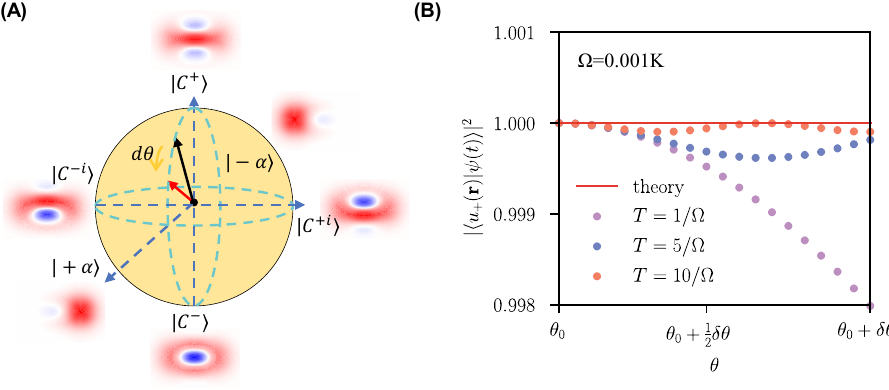
Figure 3. The dynamics process of the adiabatic evolution. ( A ) The Bloch dynamics process of the adiabatic evolution. The Wigner functions of the states at the six cardinal points on the sphere (cid:12) (cid:11) = N ± ( | + α (cid:105) ± |− α (cid:105) ) , where N ± is normalization (defined with the cat-qubit) are shown. (cid:12) C ± (cid:12) (cid:69) ± i (cid:12) = N ± ( | + α (cid:105) ∓ i |− α (cid:105) ) . ( B ) The fidelities for the numerical and theoretical factor. Similarly, i (cid:12) C results, respectively, with θ 0 = π /4, φ 0 = 0 and δθ = π /32, Ω = 0.001 K , P = K , T = 100/ Ω , (cid:12) (cid:12) (cid:12) (cid:11) = (cid:11) + (cid:11) e i φ r = ( sin θ cos φ ,sin θ sin φ ,cos θ ) , cos θ sin θ and | ψ ( t ) (cid:105) is the quantum (cid:12) u + ( r ) (cid:12) C + (cid:12) C − 2 2 state in the